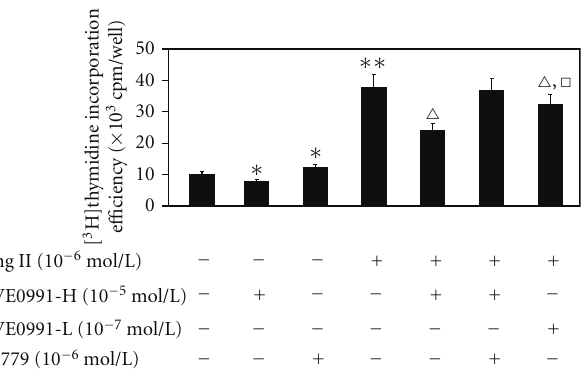
Figure 5: The e ff ect of AVE0991 on the Ang II-induced VSMCs [ 3 H]thymidine incorporation e ffi ciency with pretreatment with the HO-1 inhibitor ZnPPIX. ∗∗ P < 0 . 01 versus control group; (cid:5) P < 0 . 05; (cid:5)(cid:5) P < 0 . 05 versus Ang II group; (cid:2) P < 0 . 01 versus Ang II + AVE0991 group; n = 8.